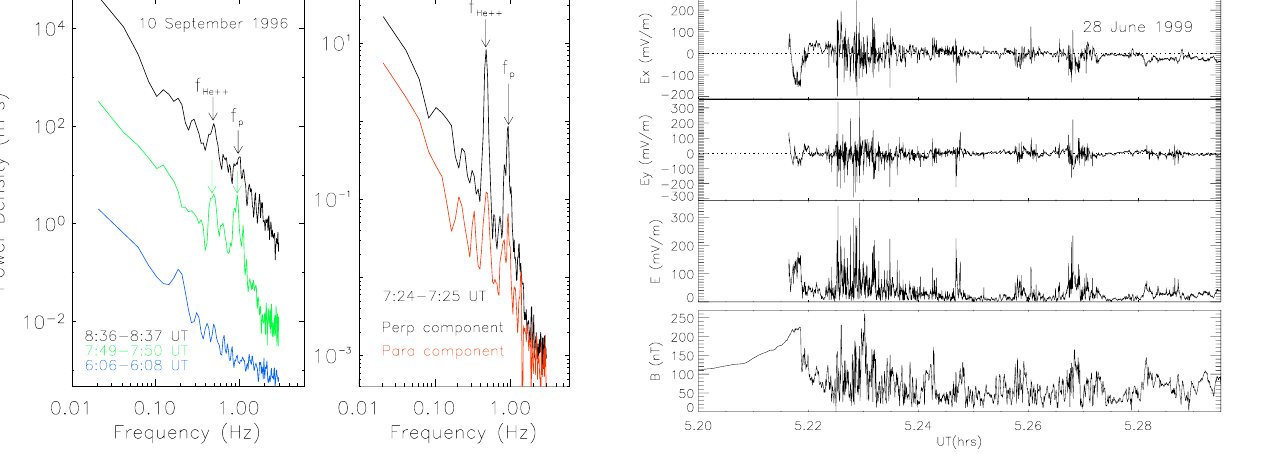
Fig. 3. The left panel is the total magnetic power spectra for fluctua- tions in the ULF range at three different 60-s periods on 10 Septem- ber 1996. The right panel is the perpendicular and parallel power spectra at 07:24–07:25UT on that day.